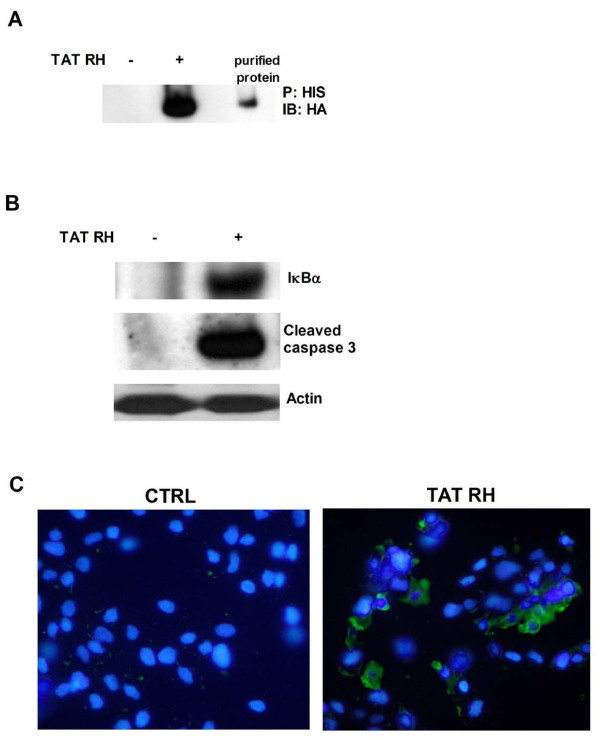
Biological effects of TAT-RH in KAT-4 cells. A) To evaluate the ability of the recombinant protein to autonomously enter into cells, we added TAT-RH (0,5 μg/ml) for 1 hour to culture medium and prepared cell lysates after three washes with saline buffer. We then evaluated the presence of TAT-RH in cell lysates by means of histidine precipitation and HA analysis by western blot. The purified protein was used as positive control. B) To verify the biological effect of TAT-RH, we evaluated IκBα and cleaved caspase 3 levels which were both increased by treatment. Actin was used as control. C) Apoptosis was also analized by Annexin V staining. TAT-RH increases Annexin V staining compared to controls (green = Annexin V; blue = nuclei).